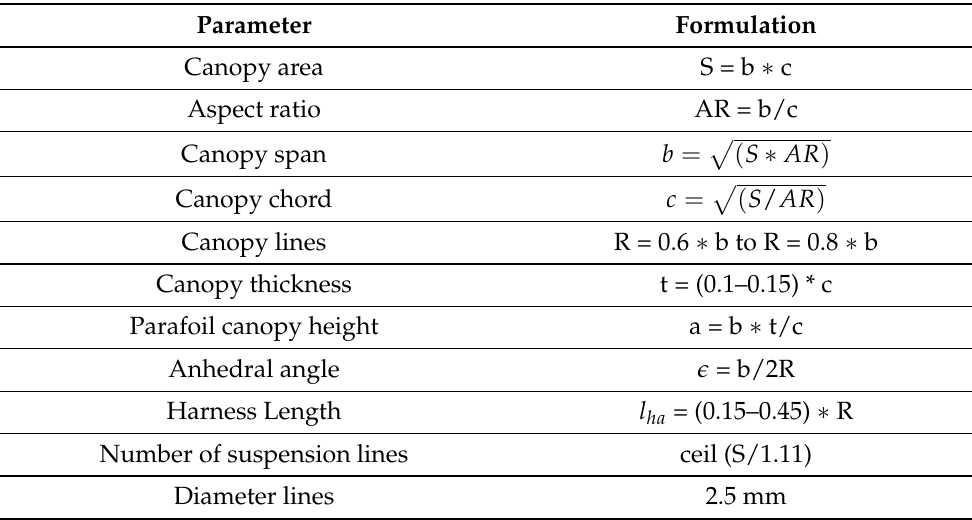
Table 1. Parafoil geometrical parameters’ estimation